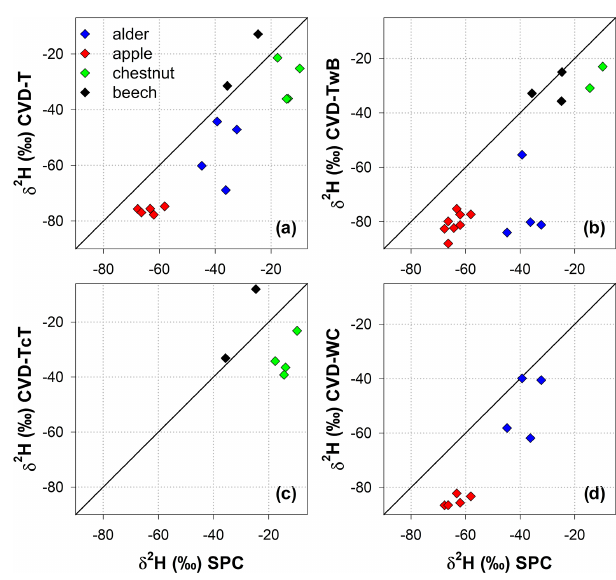
Figure 5. Relation between δ 2 H values in plant water extracted by SPC (i.e., Scholander-type pressure chamber) and CVD (i.e., cryo- genic vacuum distillation), grouped by plant tissue and species. The solid black lines represent the 1 : 1 line.